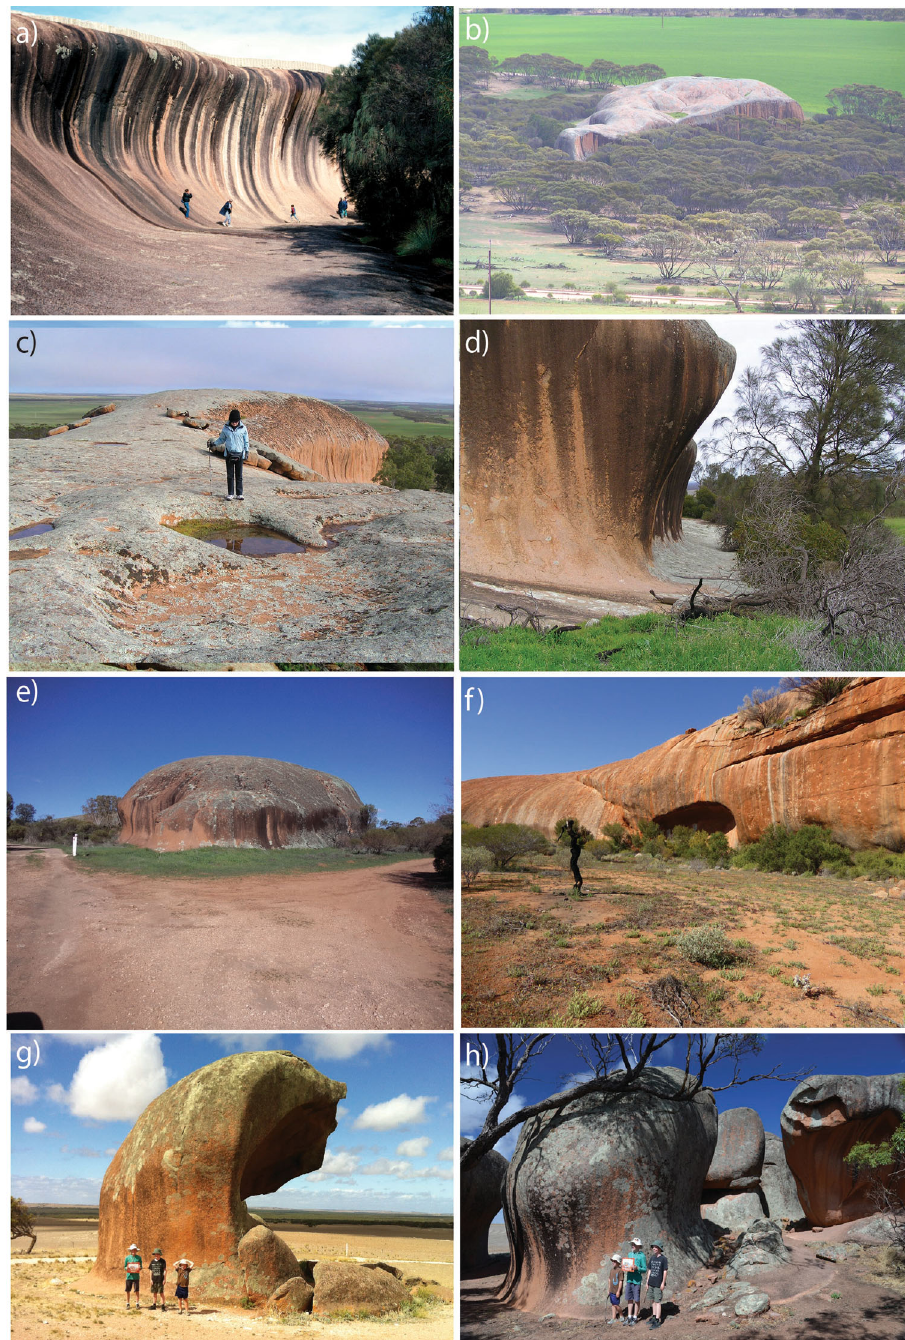
Fig. 3 Flared slopes around the periphery of prominent inselbergs. a A 15 m high fl ared slope at Katter Kich (Wave Rock), Hyden, Western Australia. A thin wedge of soil overlies fresh, unweathered granite and becomes progressively deeper away from the inselberg enabling the growth of dense, fl ammable vegetation, which encroaches on the inselberg. b Flared slopes developed in granite at Turtle Rock, Eyre Peninsula, South Australia, surrounded by dense vegetation. The photo was taken from atop Mount Wudinna looking NW. c The top of Pildappa Rock, Eyre Peninsula, South Australia is covered in old, lichen growths whilst the fl anks are relatively devoid of any lichens. d , e Well-developed fl ared slope on the margin of Pildappa Rock showing encroaching vegetation growing on a thin veneer of soil. f Walga Rock in Western Australia showing dense vegetation around the periphery of the inselberg due to the “ roof and gutter ” effect of the emergent, impermeable granite inselberg. g , h Murphy Haystacks in South Australia displaying fl ared slopes at ground level on all sides of the granite inselberg. Overhanging caves develop on the right side due to the prevailing south-westerly winds in this region, which would control the direction from which most fi re fronts would approach the